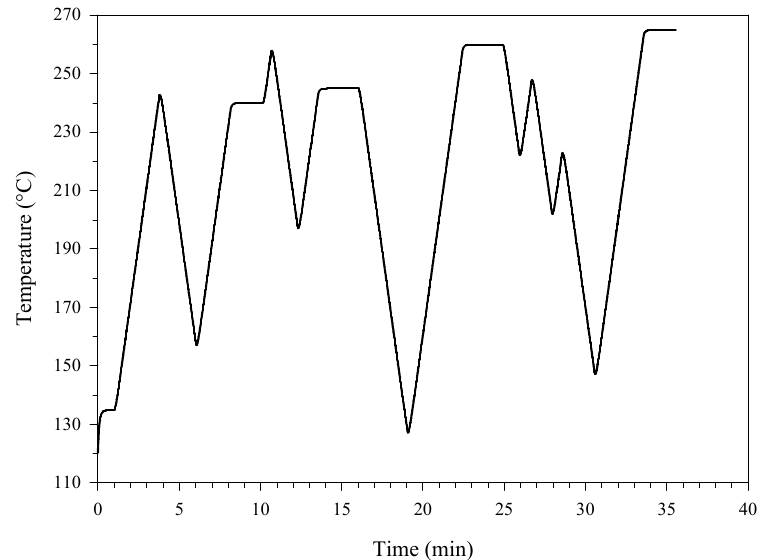
Figure 1. Temperature of PA as a function of time: non-isothermal accelerated aging test during which the sample was subjected to a complex thermal history.